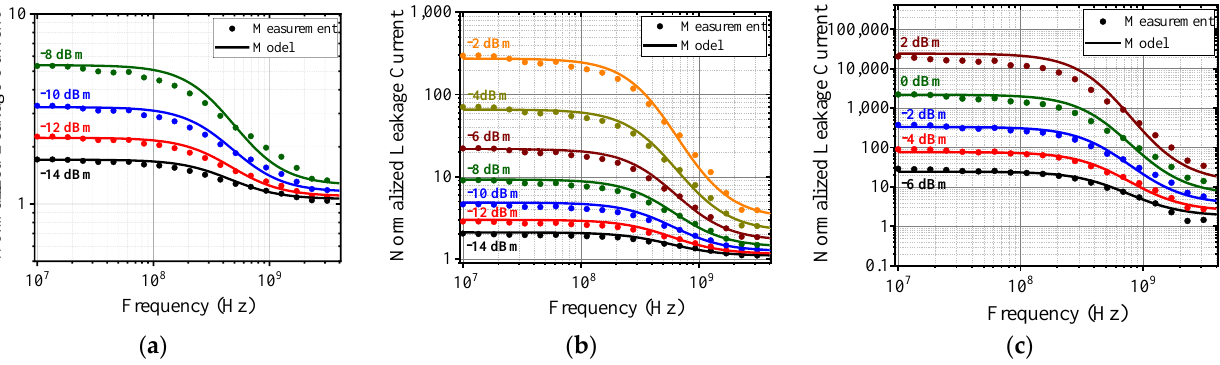
Figure 12. Comparison between the analytical model and the measured data for leakage current of NMOS for ( a ) 65 nm, ( b ) 130 nm, and ( c ) 180 nm technology node.